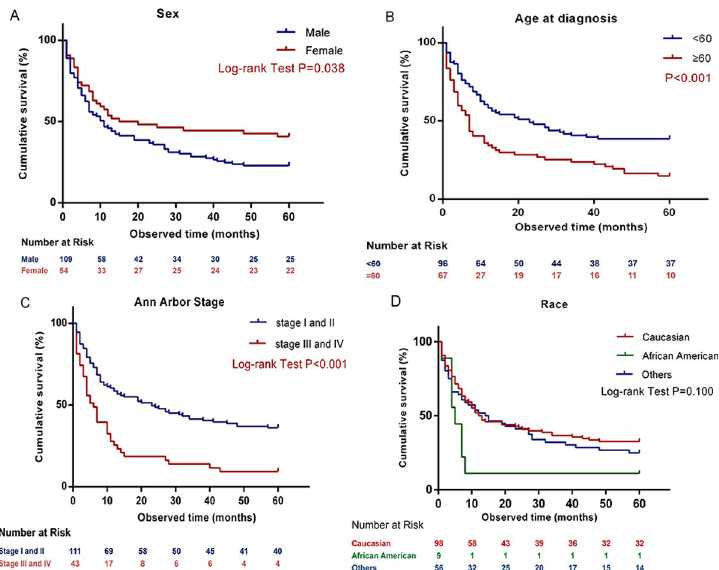
Fig 1. Kaplan-Meier curves for comparison of patients diagnosed with extra nodal natural killer/T-cell lymphoma, nasal type according to (A) Sex, (B) Age at diagnosis, (C) Ann Arbor Stage and (D) Race. https://doi.org/10.1371/journal.pone.0214860.g001 The survival rates for 2-year, 3-year and 10-year follow up were 39.9%, 33.7%, and 28.8%, respectively (Table 2). The survival rate dropped quickly in males, other races (including American Indian-Alaska Native, Asian and Pacific Islander), and patients with older age. Consistently, Cox proportional hazards regression showed that diagnosis at older age ( P < 0.001) was associated with worse survival (Table 3). In addition, African Americans were